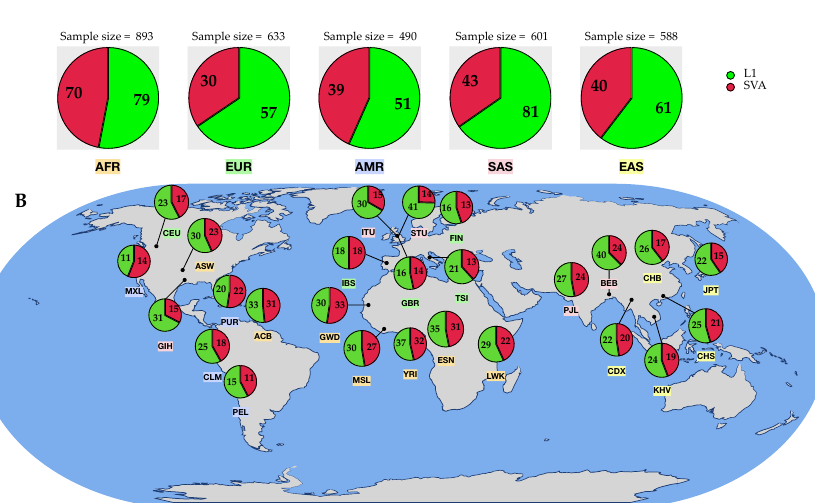
Figure 4. Overview of the identified (high-confidence) transduction variants based on their origin region. ( A ) Sample size and total count of identified polymorphic transductions across the five super- populations (AFR = African, AMR = American, EUR = European, SAS = South Asian, EAS = East Asian). ( B ) Number of transduction loci per sub-population. Sub-populations are color-coded based on their continental populations (Table